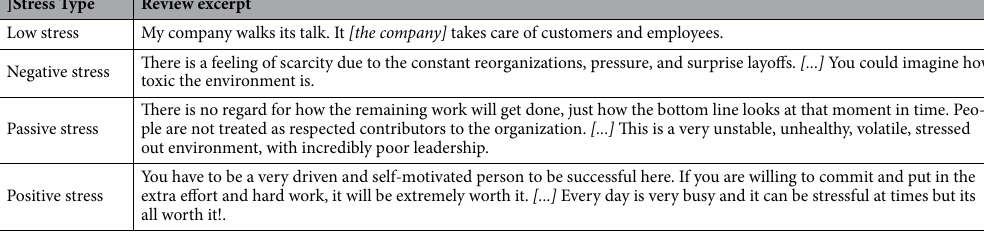
Table 1. Example reviews of companies of each stress